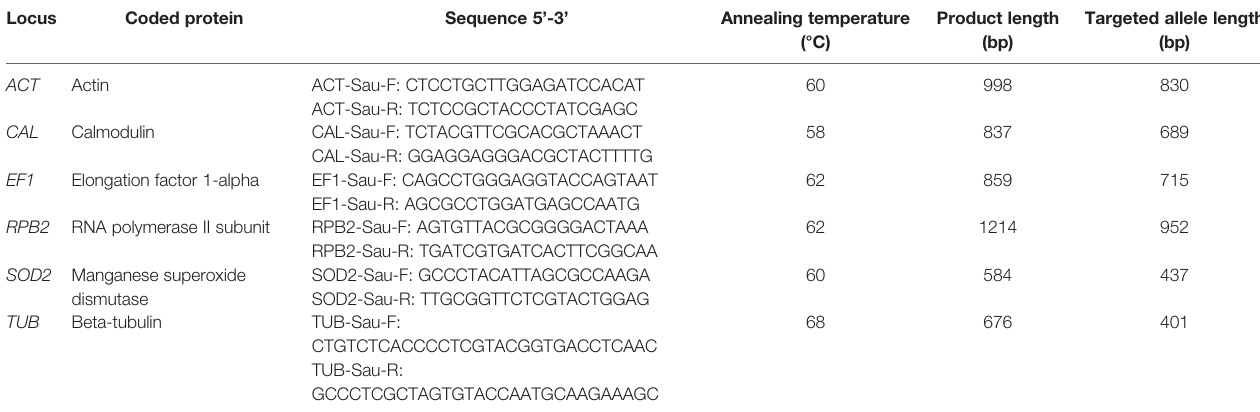
TABLE 1 | Selected gene loci, primer sequences and annealing temperatures used in the consensus MLST scheme for Scedosporium aurantiacum strain typing. Locus Coded